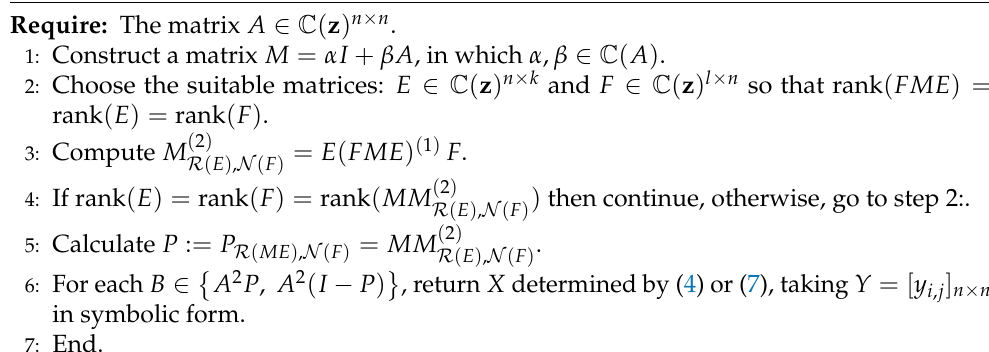
Algorithm 2 Solving the singular (resp. nonsingular) YB-like matrix Equation (1) using Theorem 2 in conjunction with Theorem